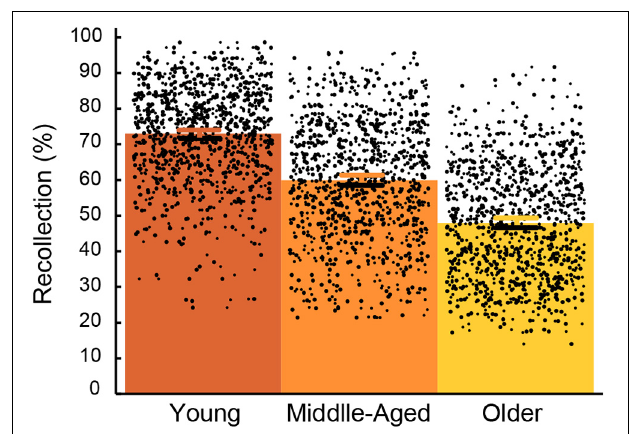
FIGURE 1 | Mean and individual recollection performance in young (21–40 years old), middle-aged (41–60 years old) and older adults (61–80 years old). Error bars represent the 95% confidence intervals for the mean.